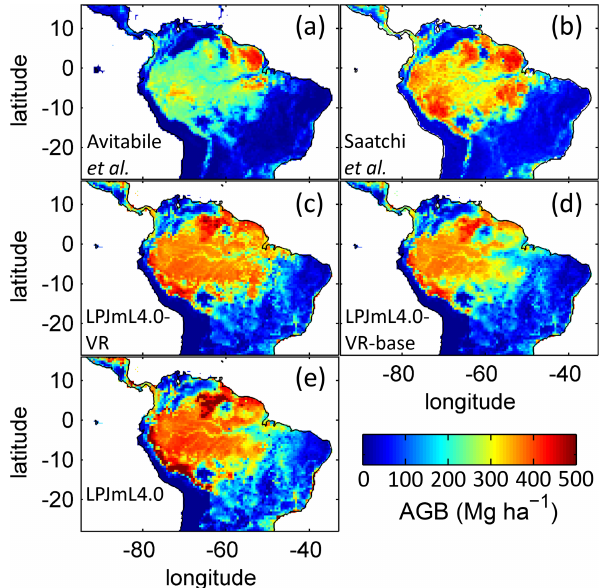
Figure B10. Comparison of simulated AGB and satellite-derived AGB validation products regridded to the spatial resolution of LPJmL models. (a) Biomass validation product from Avitabile et al. (2016). (b) AGB validation product from Saatchi et al. (2011). (c–e) Mean AGB simulated for the time span 2001–2010 with (c) LPJmL4.0-VR, (d) LPJmL4.0-VR-base and (e) LPJmL4.0. For sta- tistical measures of individual comparisons between model versions (c–e) and satellite-derived AGB evaluation products (a–b) , see Ta- ble